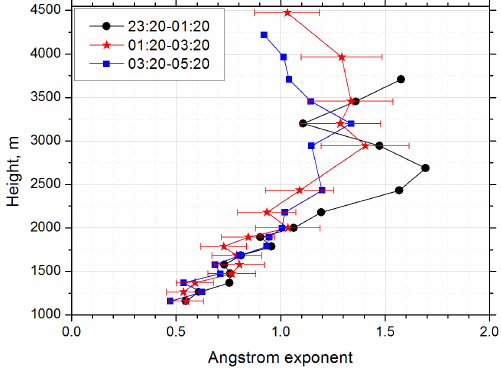
Figure 9. Ångström exponent for time intervals 23:20–01:20, 01:20–03:20 and 03:20–05:20UTC on 27–28